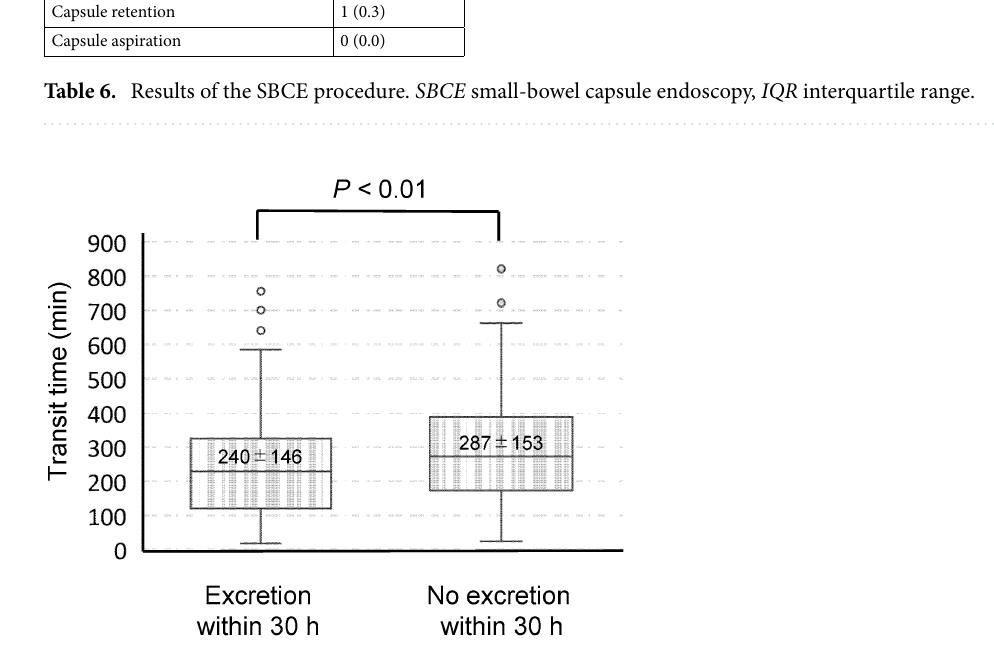
Figure 2. PC excretion within 30 h was associated with SBCE transit time. The transit time of the small-bowel capsule endoscopy (SBCE) was compared between the excretion and nonexcretion groups within 30